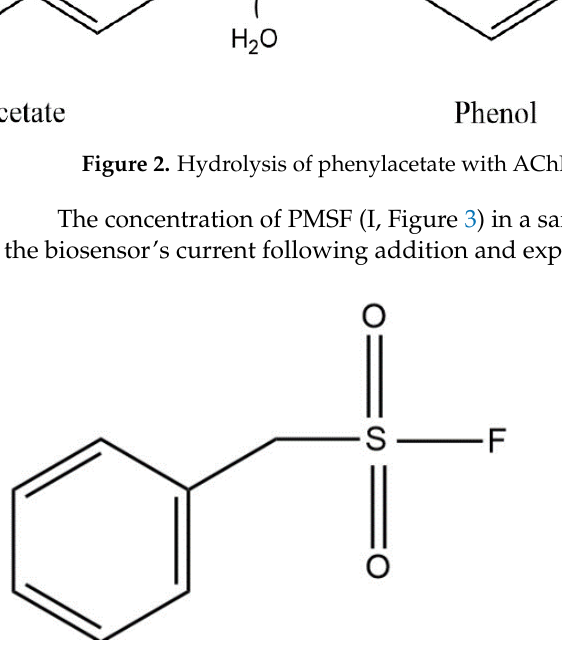
Figure 4. Inhibition mechanism of AChE (E) with PMSF (I) in the presence of substrate (S 1 ).